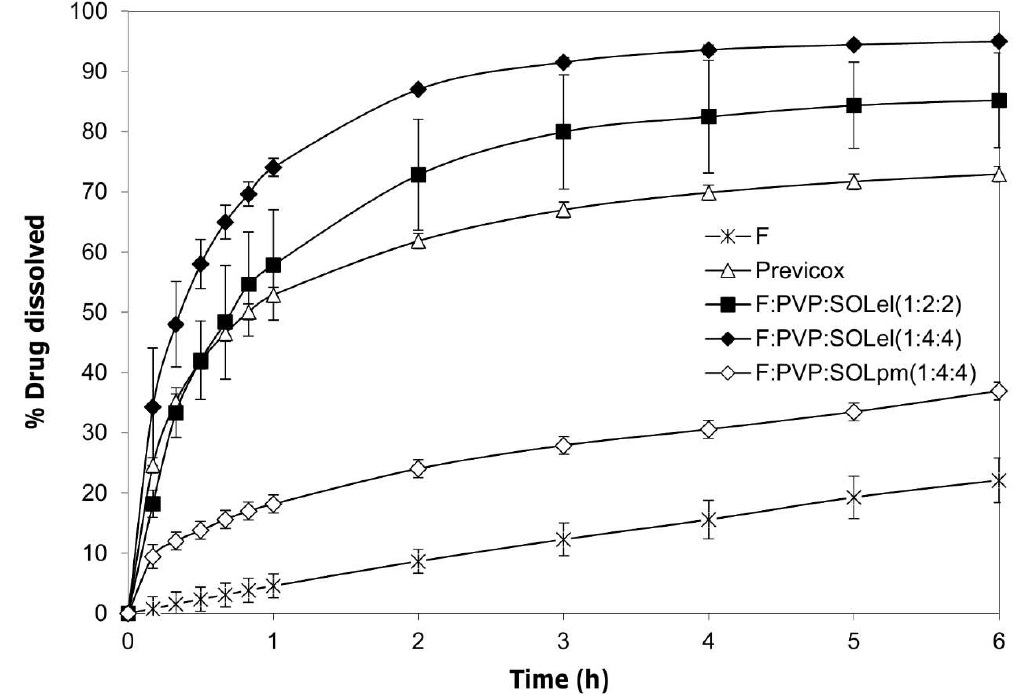
Figure 8. The carrier system containing a combination of PVP and the polymeric surfactant (polyvinyl caprolactam-polyvinyl acetate-polyethylene glycol graft copolymer) at two different concentrations.